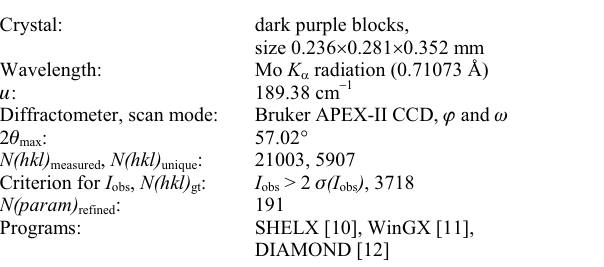
Table 1. Data collection and